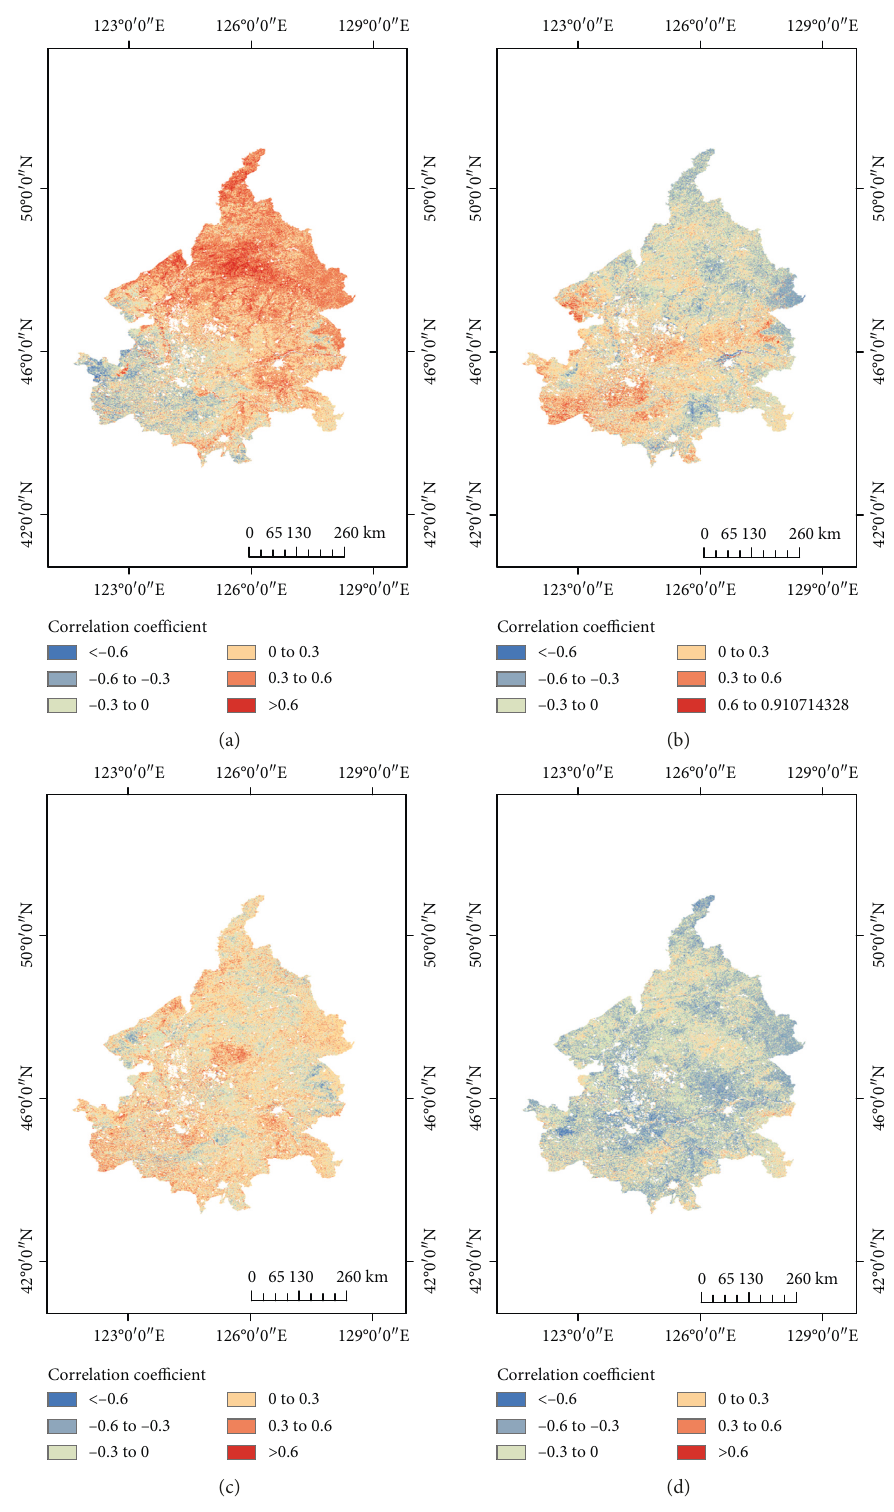
Figure 6: Correlation coefficients between CUE and major climatic factors: (a) annual precipitation, (b) total annual sunshine duration, (c) annual average relative humidity, and (d) annual average